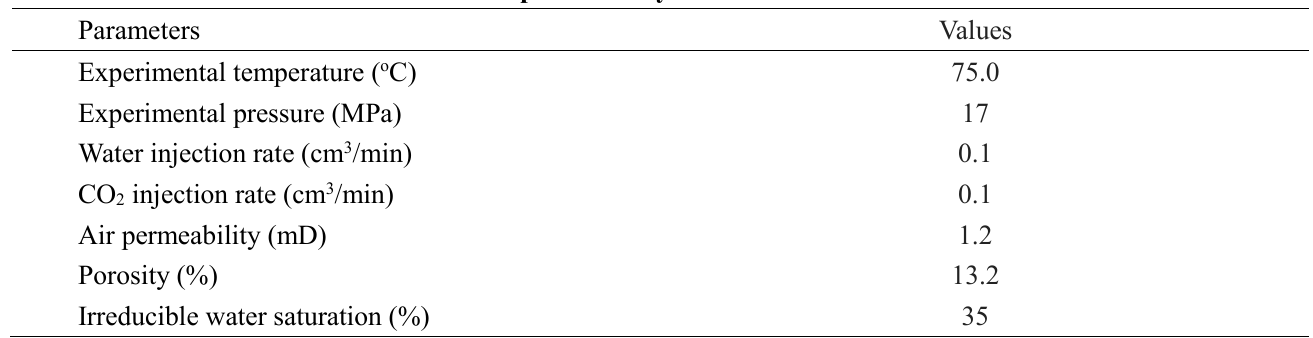
Table 2—Basic parameters and conditions of the displacement experiment of the cores from the low permeability